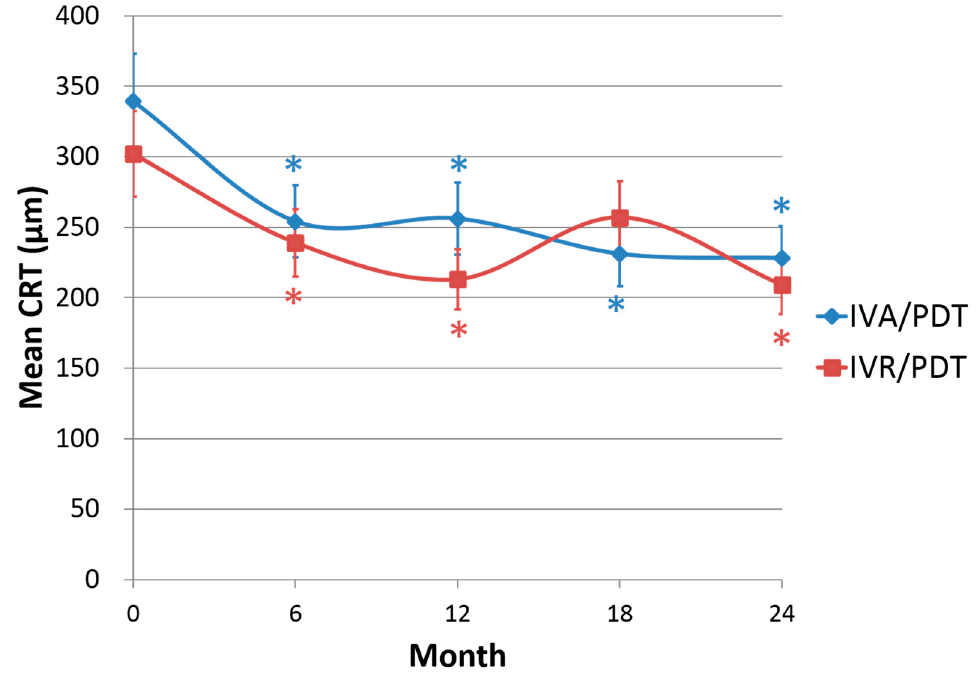
Figure 2. Change in mean central retinal thickness (CRT) (* p < 0.05). Complete polyp regression rate at 3-month was 53.3% in the IVA/PDT group, and 52.0% in the IVR/PDT group. Between the two groups, the complete polyp regression rate did not differ ( p = 0.921). In the IVA/PDT group, the dry macula rate was